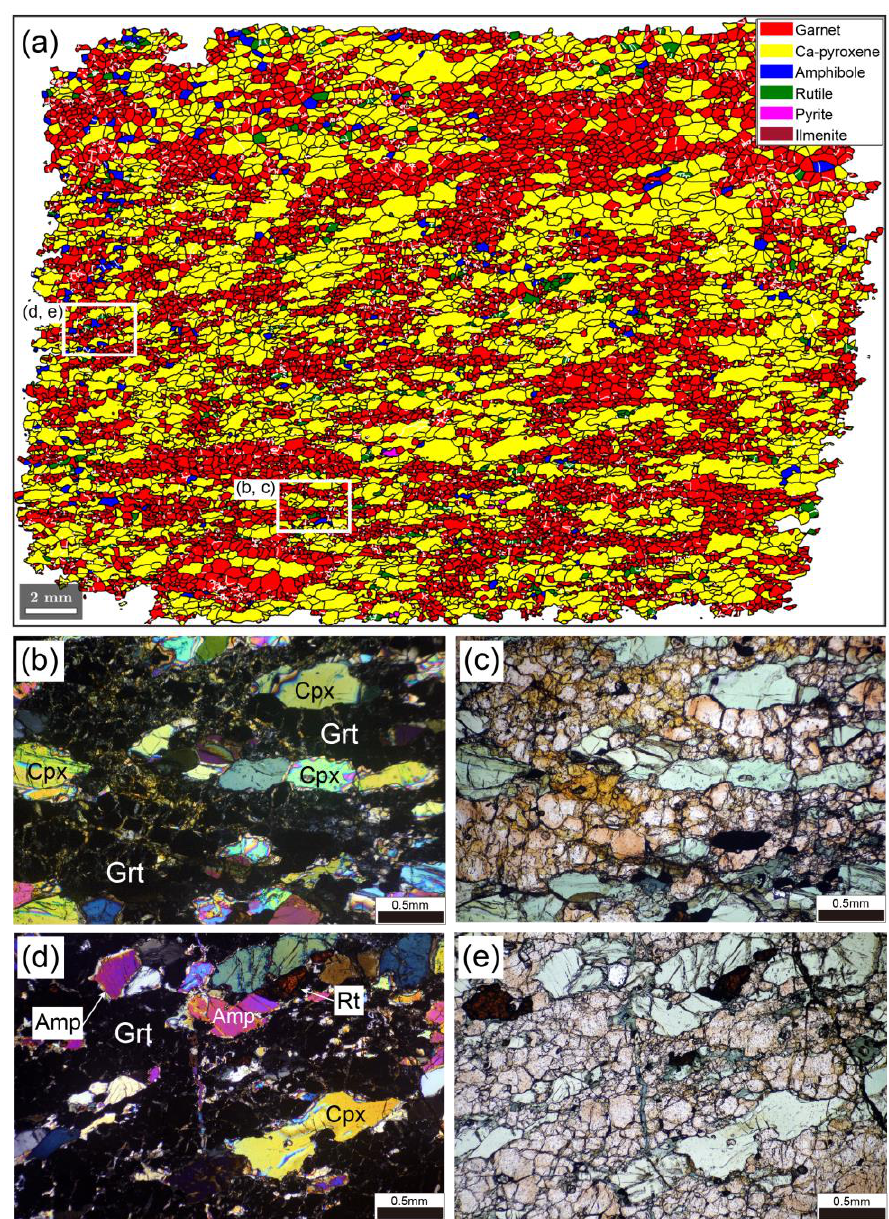
Figure 3. Microstructures of garnet clinopyroxenite. ( a ) EBSD phase map of entire thin-section. White areas in the map are non-indexed pixels. White lines represent subgrain boundaries. White rectangles indicate areas shown in ( b – e ). ( b , d ) Photomicrographs under cross-polarized light. ( c , e ) As in ( b , d ), but under plane-polarized light, respectively. Grt, garnet; Cpx, Ca-pyroxene; Amp, amphibole; Rt,